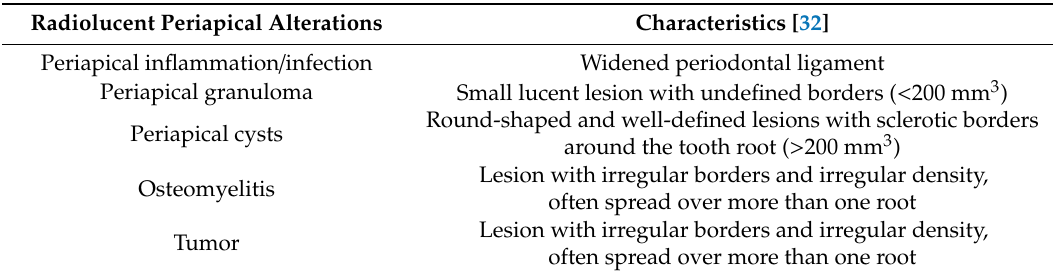
Table 1. Detailed description of the lesions considered in the study.